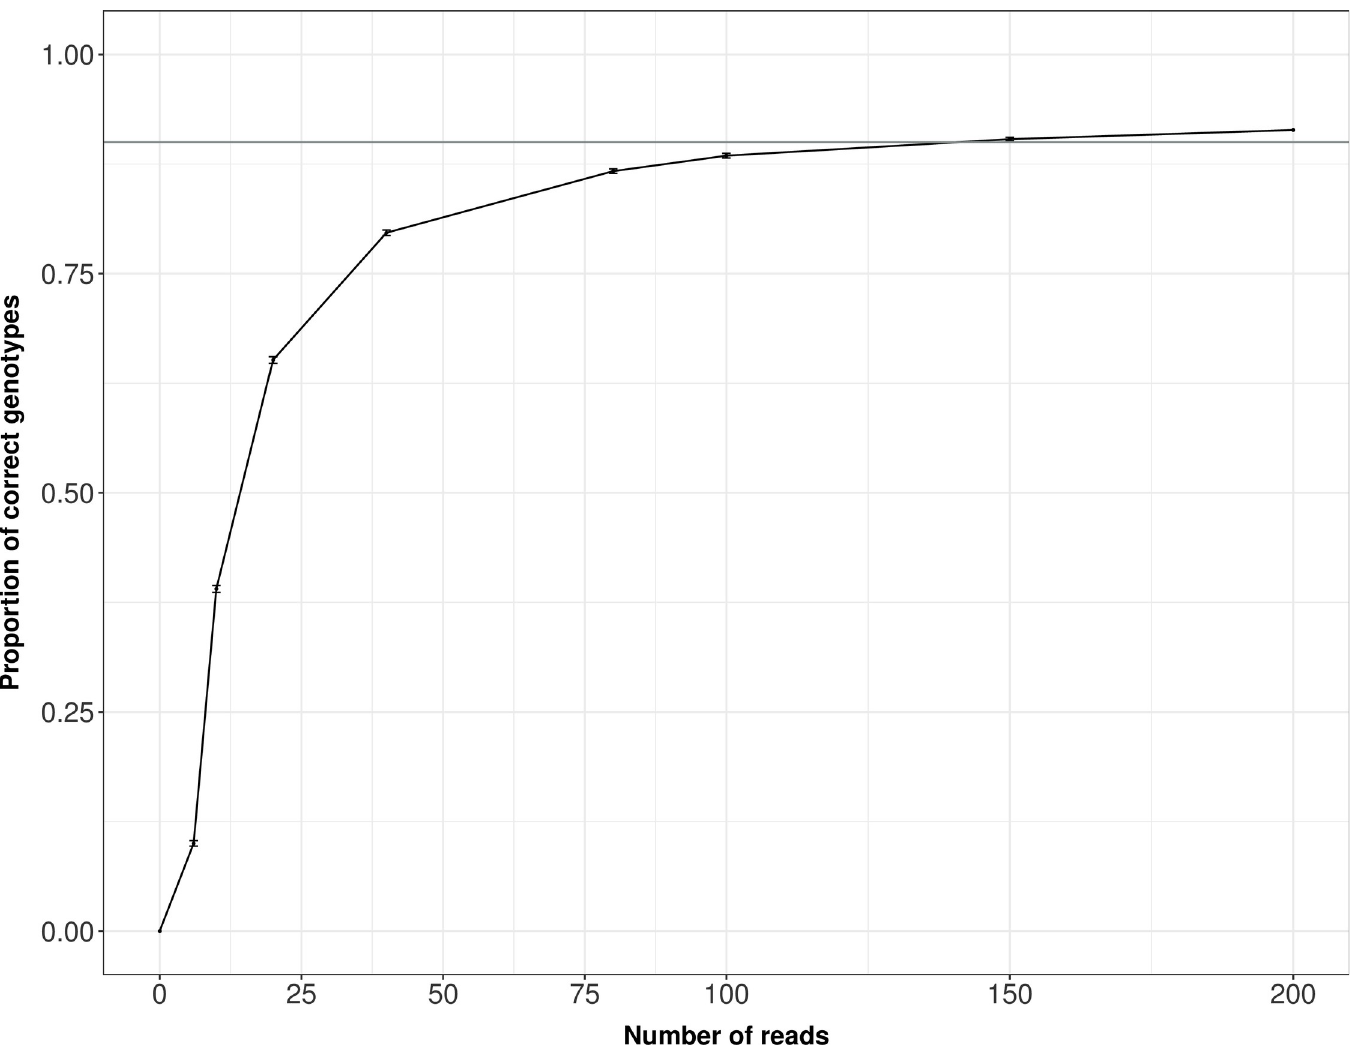
Fig 2. Relation between genotyping success and read depth per locus in Megasat. Proportion of correct genotypes using Megasat when varying the sequencing coverage. With 150 reads Genotyping success was greater than 0.9 (horizontal line). Simulations were performed with 100 random draws of a given number of reads for each locus and PCR replicate. The average of 100 random draws is represented; error bars indicate standard